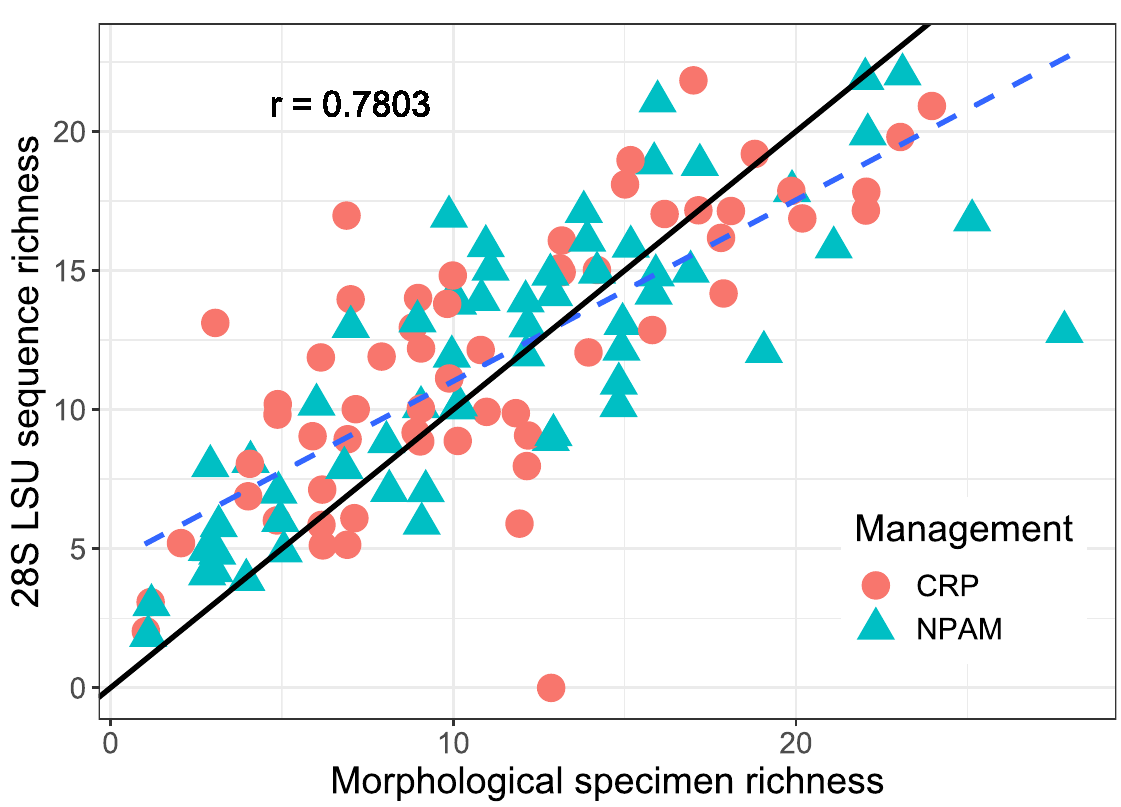
Fig 3. Morphological and molecular methods comparison. Correlation between species richness as detected by molecular sequencing (vertical axis) relative to species richness as detected by morphological specimen identification (horizontal axis), for both Conservation Reserve Program (CRP, circles) and Native Prairie Adaptive Management (NPAM, triangles) management regimes. Each marker represents a sample, the solid line represents the 1:1 reference line, and the dashed line represents the empirical best fit (r = 0.7803, p <